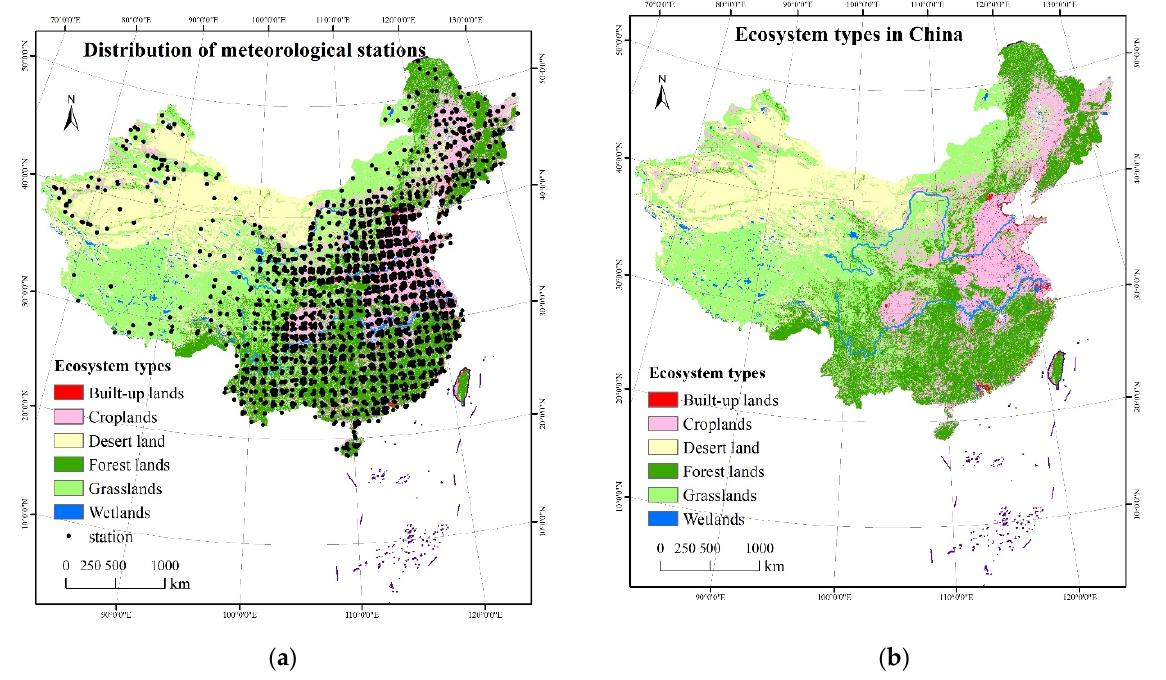
Figure 1. Locations of meteorological stations ( a ) with long-term observation data (2000–2021), and the distribution of the main ecosystem types (forest land, grass land, and unused land) ( b ) in China. NDVI derived from the 16-day spatial resolution 1 km × 1 km grid products of NASA’s moderate resolution imaging spectroradiometer (MODIS) sensors. To